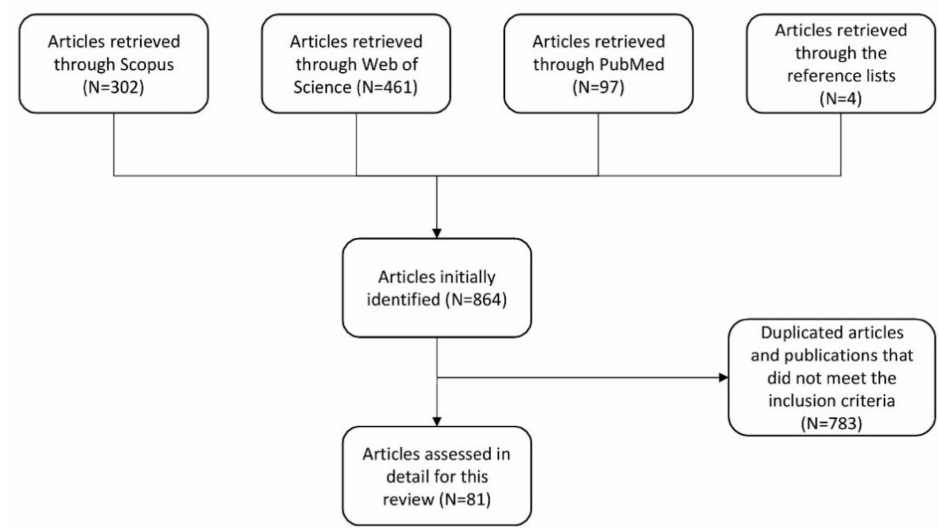
Figure 1. Search strategy for identifying scientific publications for this comprehensive review